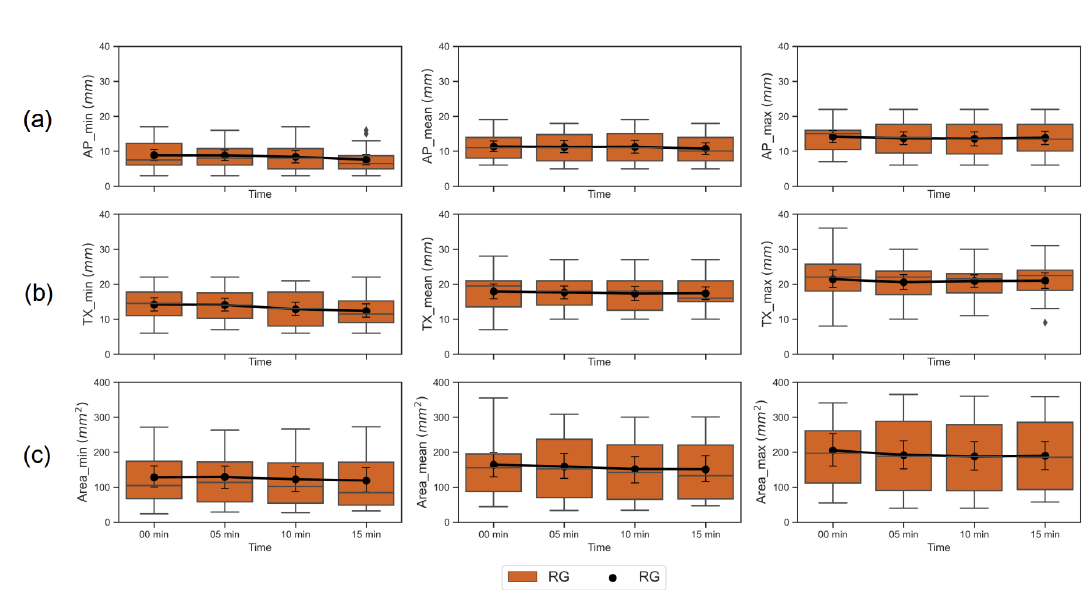
Figure 4. Box plot and a point plot with mean and 95% CI across 22 patients for each of the 9 airway dimensions (listed in Table 1) in retroglossal (RG) plane. Airway measures at the four anesthetic conditions of 00 min (DEX only, baseline), 5, 10, and 15 min after administering ketamine at the baseline condition were plotted on the x-axis. Each of the subplots represent an airway measure, row-wise: ( a ) anterior-posterior (AP) diameter (in mm), ( b ) transverse (TX) diameter in (mm), and ( c ) cross-sectional area (in mm 2 ) at the minimum (min), mean and maximum (max) airway sizes (plotted column-wise) during continuous